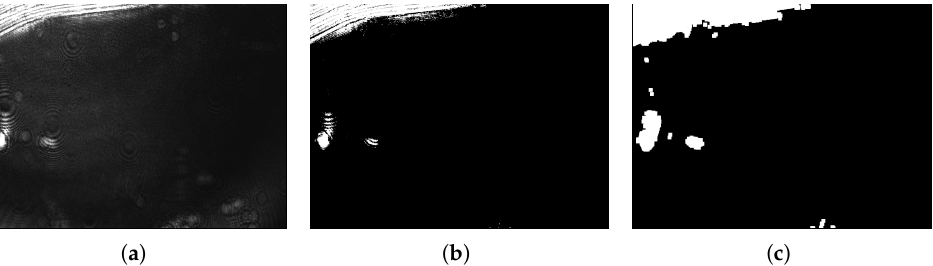
Figure 10. ( a ) example of a raw image, ( b ) the map of overexposed pixels created from the raw image by thresholding, and ( c ) a map with dilated overexposed regions for filtering out false detections at the borders of gold foil defects. The thresholding classifies each pixel of the raw image with over 50% of the possible maximum as an overexposed region. The maximum filter for dilation has side lengths of